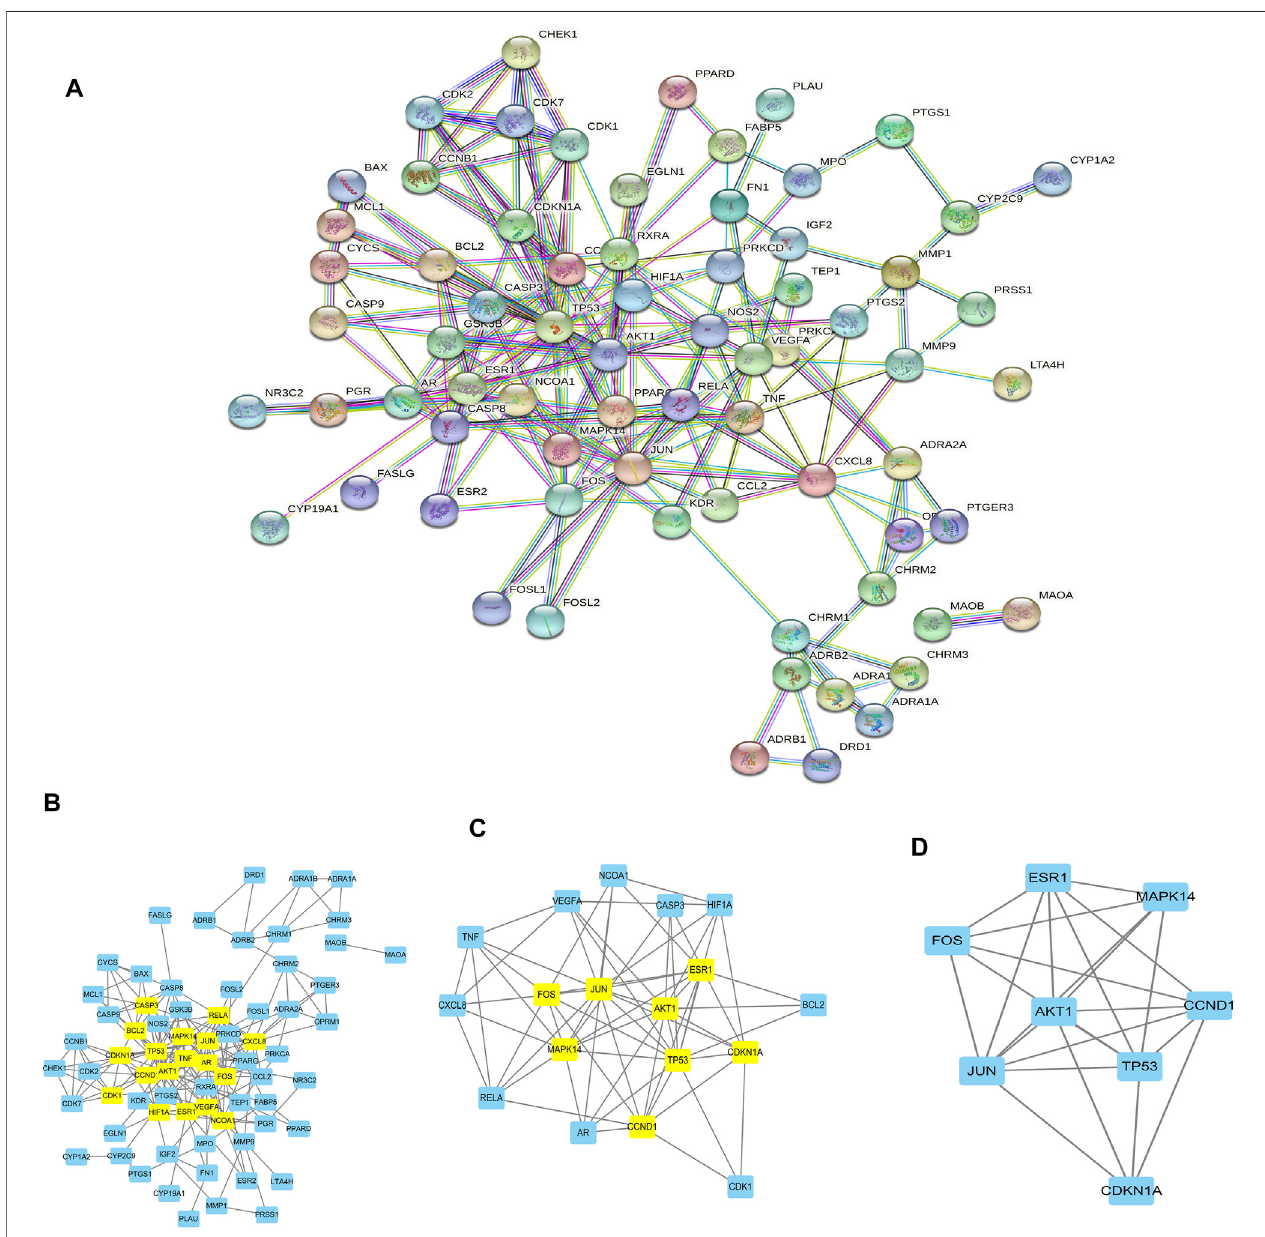
FIGURE 2 | (A) Diagram of protein interaction network of gastric cancer target genes acted by Scutellaria . (B) Topological network of gastric cancer target genes acted by Scutellaria baicalensis Georgi. (C) Further screening of target genes for drug action. (D) Eight core drug target genes of Scutellaria baicalensis Georgi.